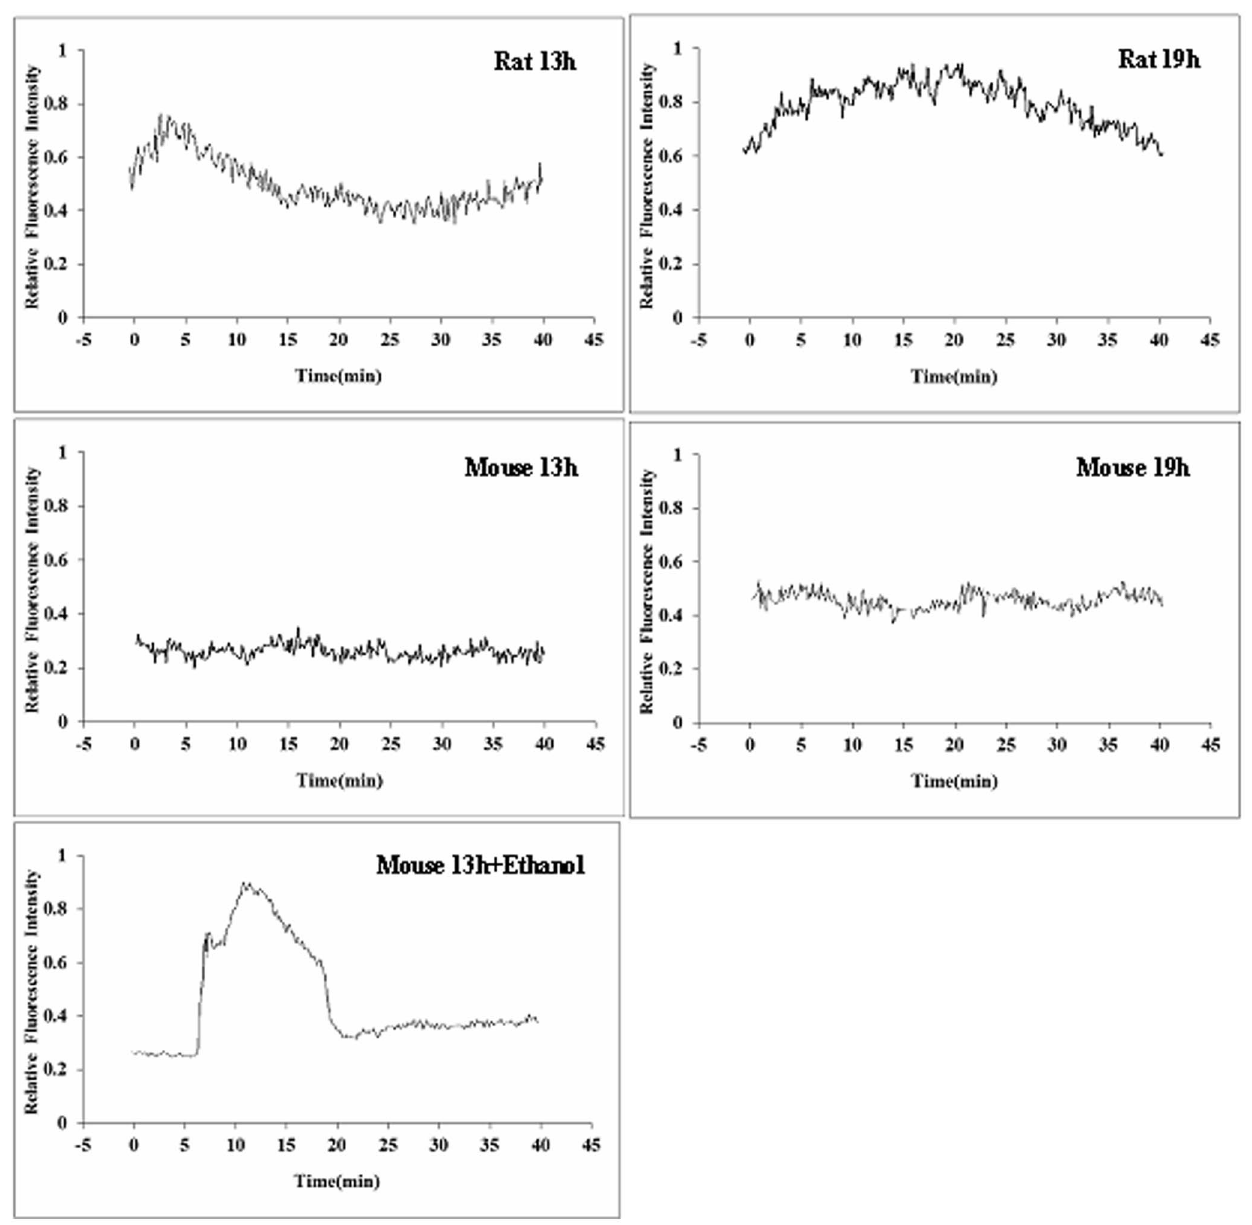
Figure 1. Calcium measurements in rat and mouse oocytes collected at 13 h or 19 h after hCG injection. Calcium was also measured after mouse oocytes recovered at 13 h post hCG were activated with 10% ethanol for 10 min (Mouse 13h + Ethanol). Oocytes recovered at different times were cultured for 40 min in M2 (mouse) or HR1 (rat) and the calcium concentrations were measured during the culture. Each treatment was repeated three times, with each replicate containing about 20